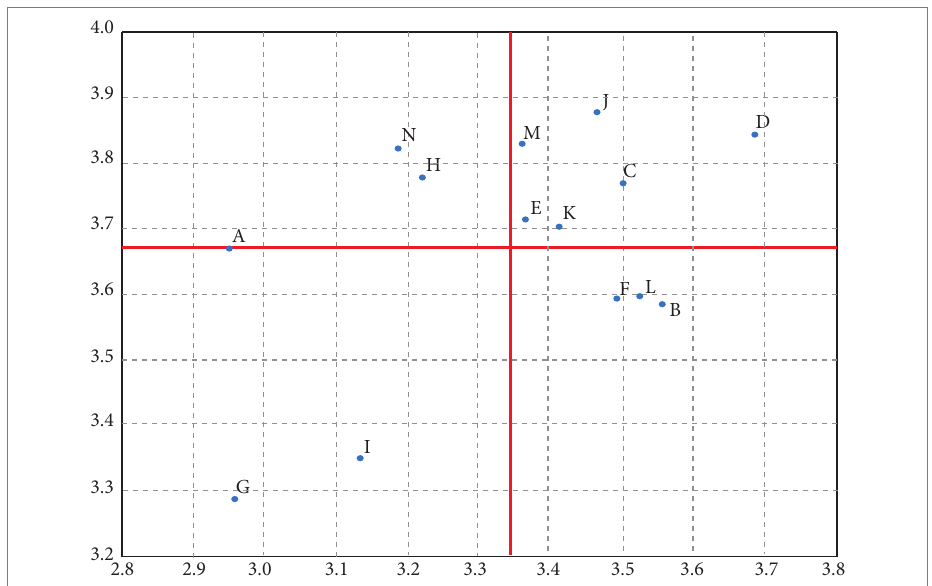
Fig. 10. The scatter diagram of parameters of relations of Slovak enterprises with the equipment